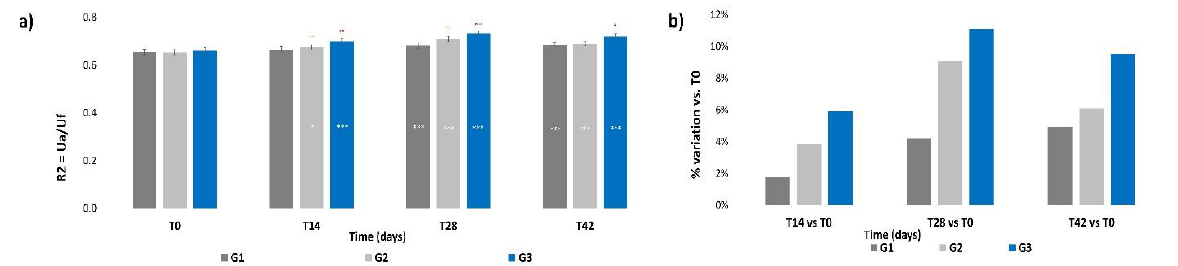
Figure 4. Skin elasticity. The graphs show data obtained at each monitored time for the three groups. ( a ) Data are expressed as mean ± SEM of the R2 parameter (Ua/Uf). ( b ) Data are reported as mean percentage variation with respect to T0. Legend = *** p < 0.001 vs. T0, * p < 0.05 vs. T0, °° p < 0.01 G2 vs. G1, ° p < 0.05 G3 vs. G1, °° p < 0.01 G3 vs. G1, °°° p < 0.001 G3 vs. G1.